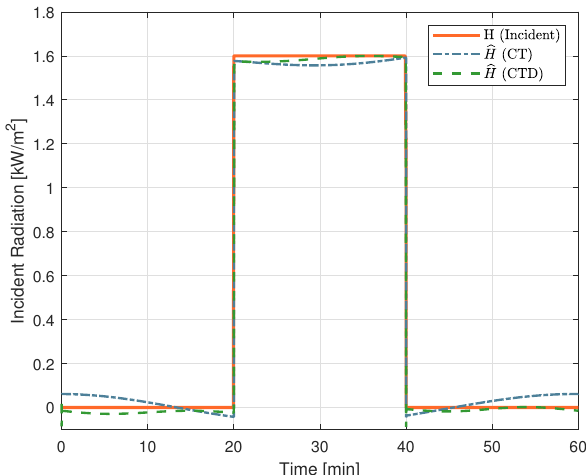
Figure 10. Estimation of Incident Radiation in SPICE